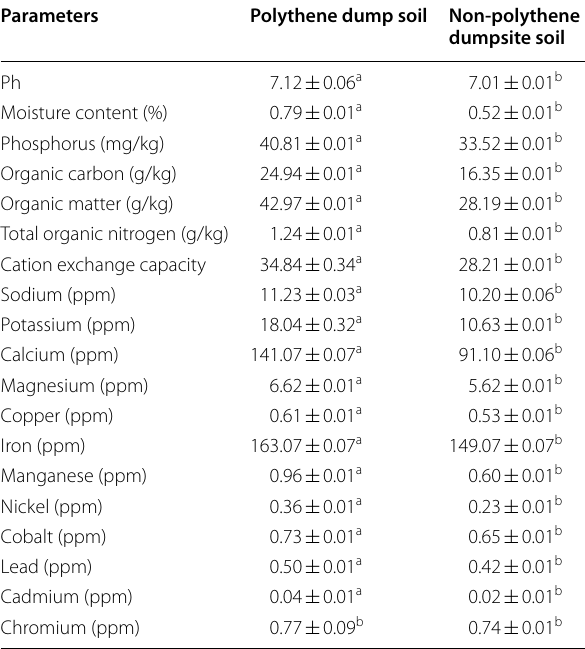
Key Parameters with different alphabetical labels (‘a’ and ‘b’) along the same row are significantly different from each other, while the parameter with the same alphabetical label is not significantly different